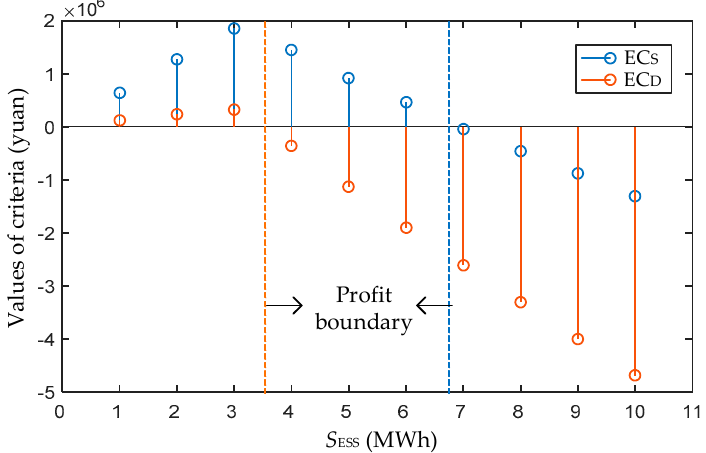
Figure 8. Values of two criteria with different ESS capacity deployments.